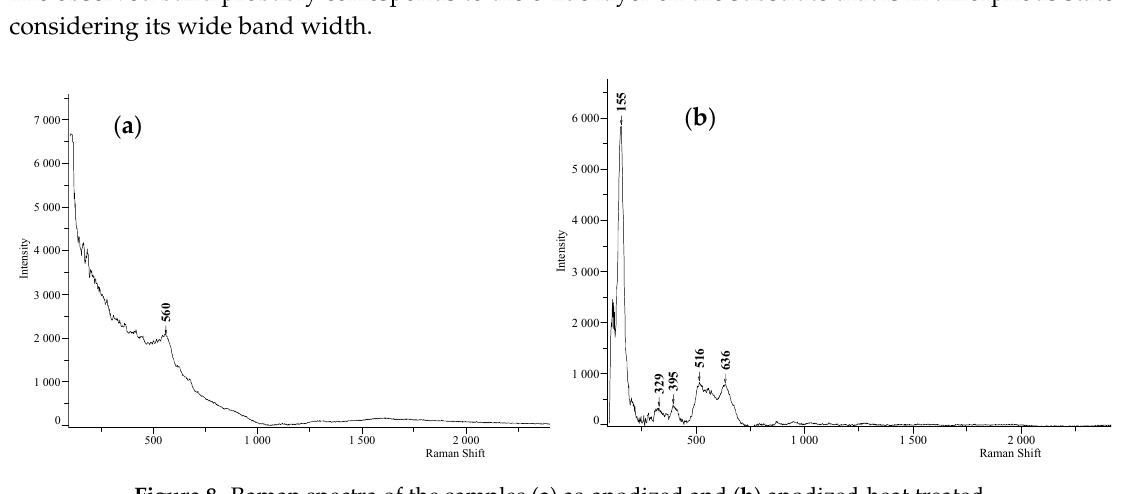
Figure 8. Raman spectra of the samples ( a ) as-anodized and ( b ) anodized-heat treated.